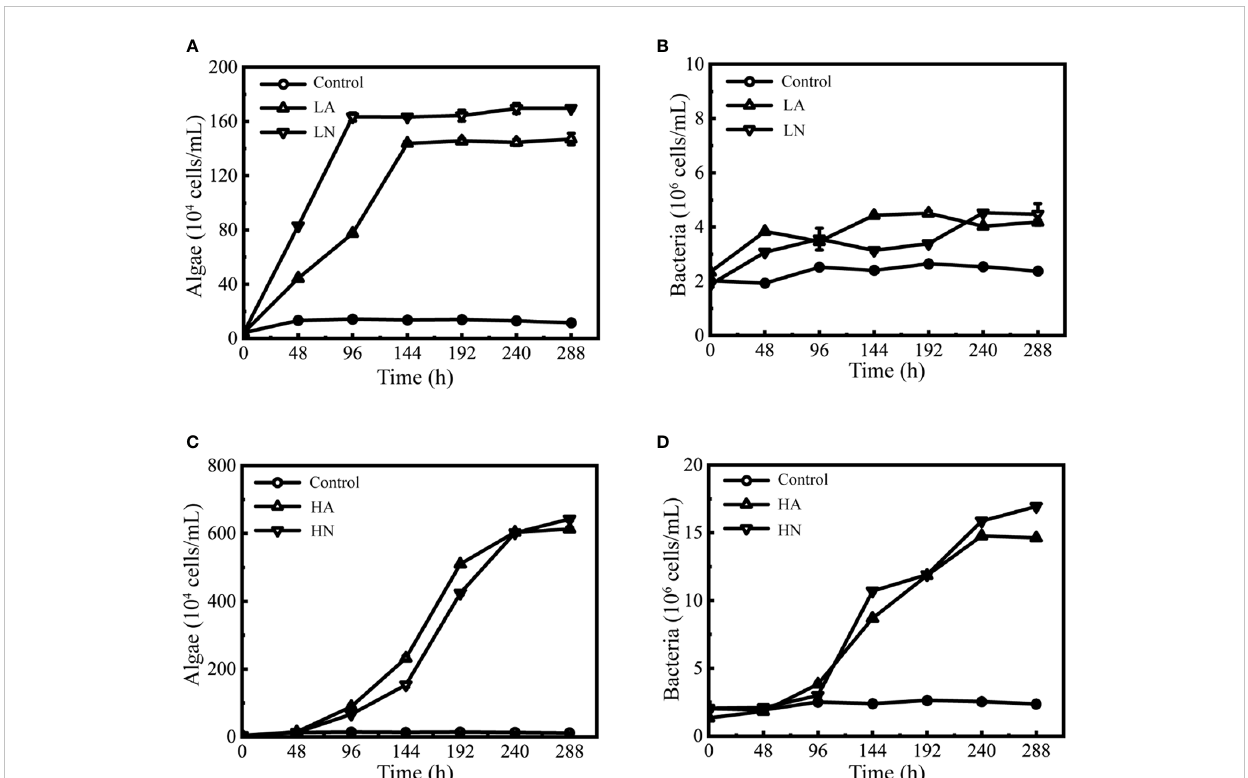
FIGURE 1 Growth curves of Phaeodactylum tricornutum and associated phycosphere bacteria co-cultured in different conditions. Biomass of P. tricornutum under different conditions (A, C) . Biomass of the phycosphere bacteria under different conditions (B, D) . The meaning of each group abbreviation is shown in Table 1. Error bars indicate the standard deviation (SD) of three independent